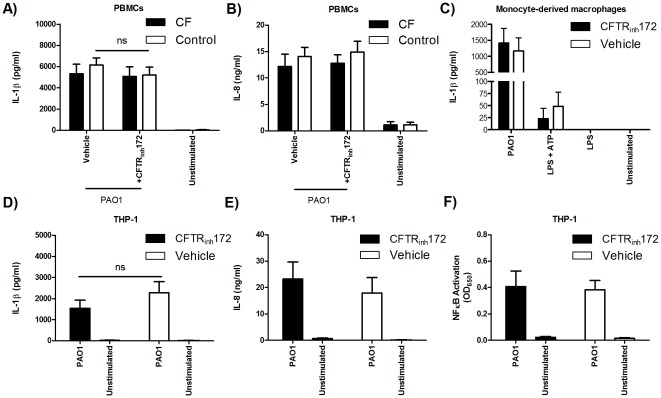
Disruption of CFTR activity does not increase IL-1β production in PBMCs or macrophages.PBMCs from CF patients (n = 15) and controls (n = 13) were treated with CFTRinh172 (10 µM) for 18 hours prior to stimulation with live PAO1 (MOI = 1). (A) IL-1β and (B) IL-8 production was measured at 24 hours. (C) Monocytes from controls (n = 3) were differentiated into macrophages. Macrophages were treated with CFTRinh172, stimulated as per monocytes, and measured for IL-1β production at 24 hours. THP-1 reporter cells were treated with CFTRinh172 24 hours prior to stimulation with PAO1 and measured for (D) IL-1β secretion, (E) IL-8, and (F) NF-κB/AP-1 activity at 24 hours (n = 4).